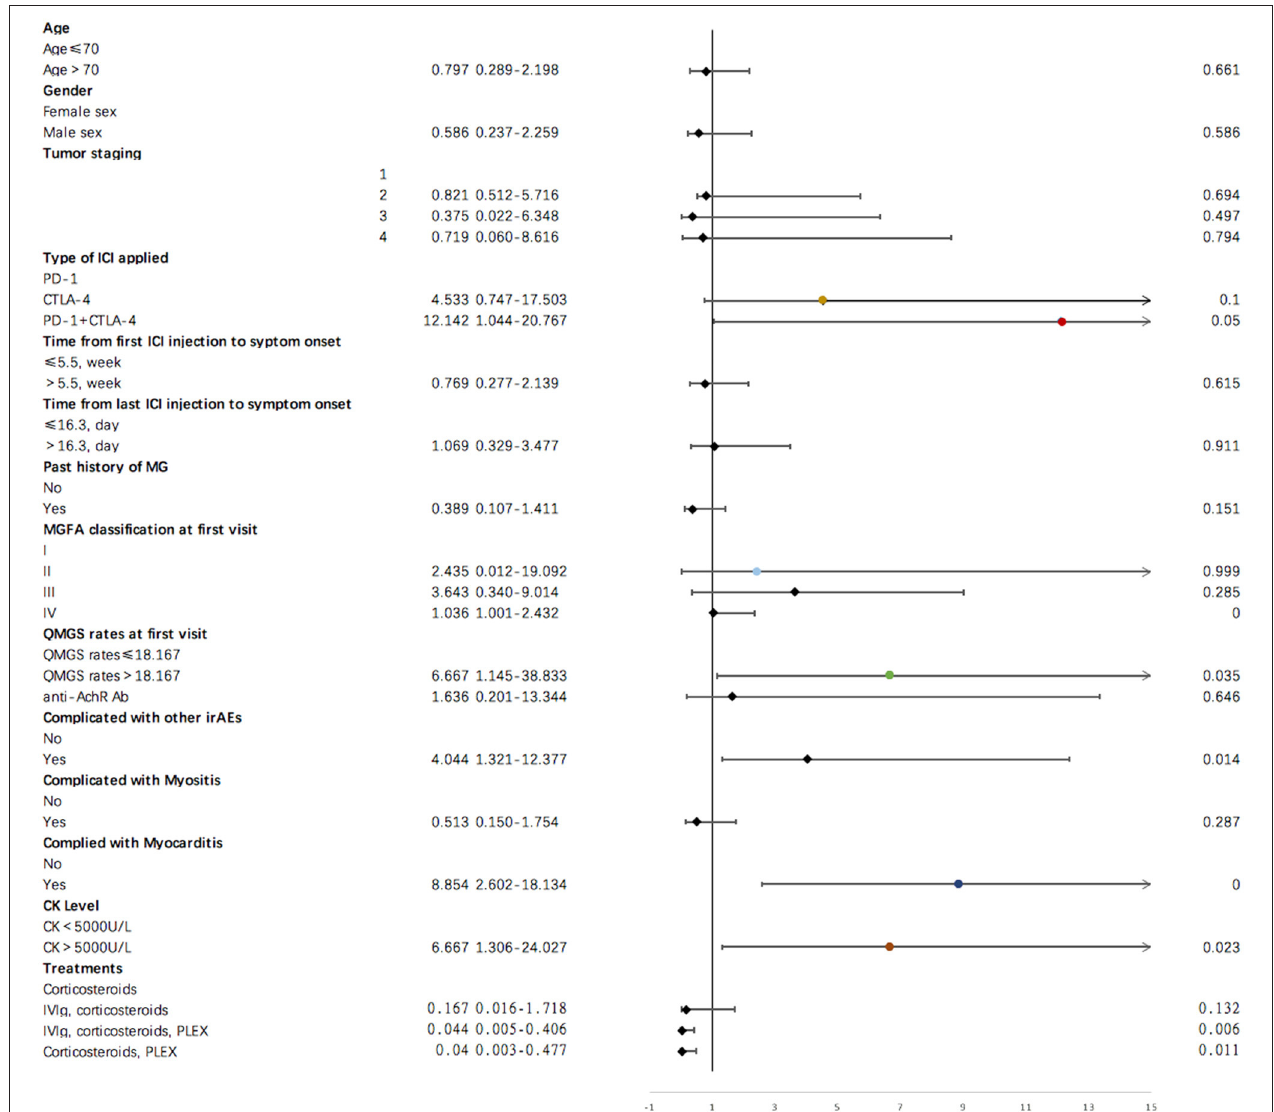
FIGURE 2 | Results of single variate binary logistic regression for demographic and clinical factors and irMG